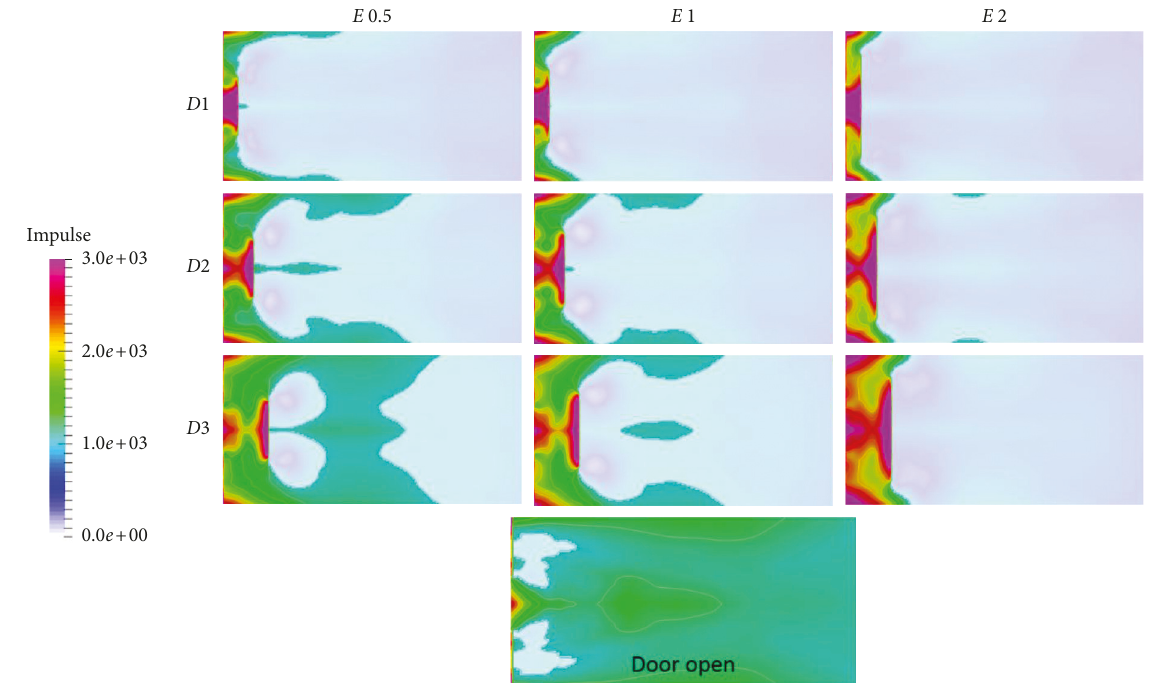
Figure 9: Zone of impulse higher than 1000Pa and impulse in pa s). ·